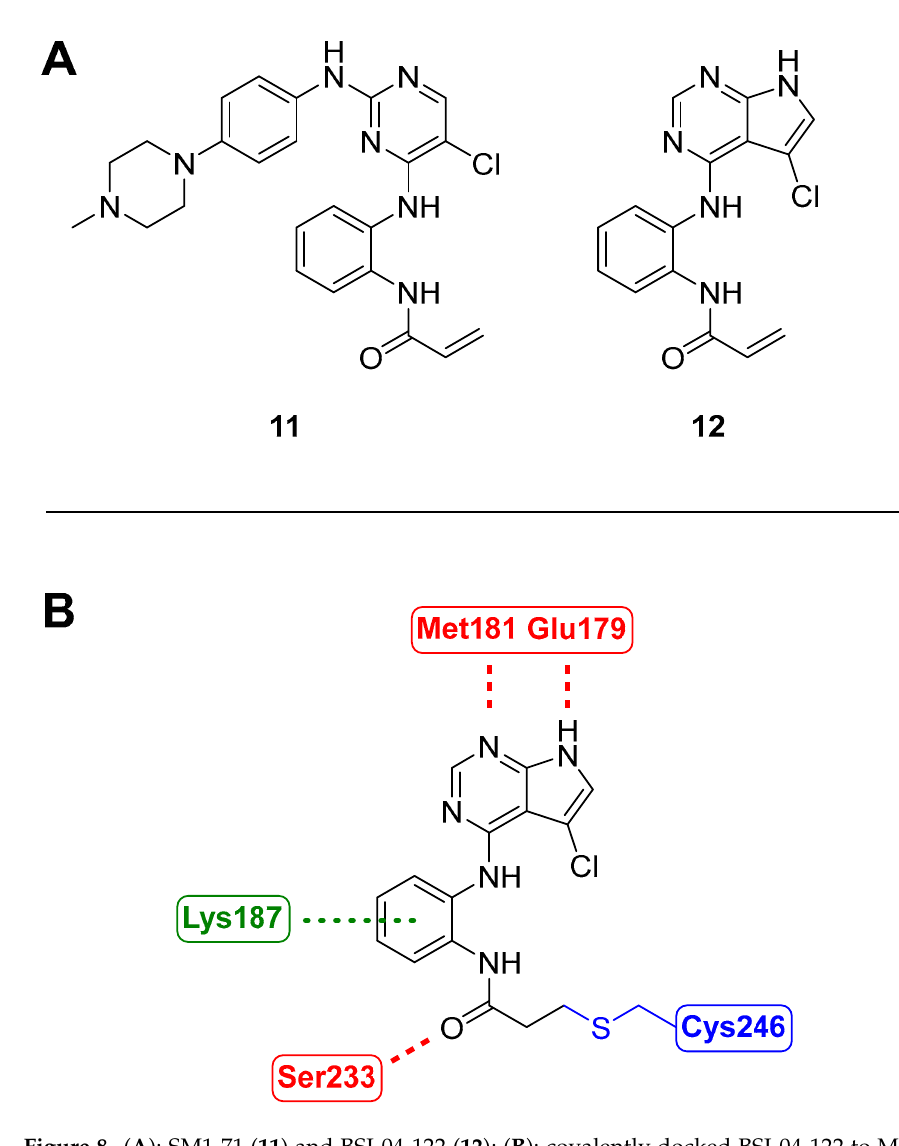
Figure 8. ( A ): SM1-71 ( 11 ) and BSJ-04-122 ( 12 ); ( B ): covalently docked BSJ-04-122 to MKK4 (3aln) according to Jiang et al. [26].